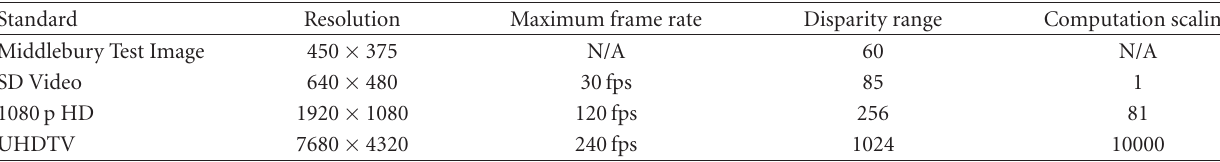
Table 6: Common resolutions, frame rates, and disparity ranges (disparity range is computed with the same image sensor size (17.3mm 2 ), focal length (2.5mm), distance between cameras (12mm) and image depth (0.5m) for each image resolution. Parameters are based on